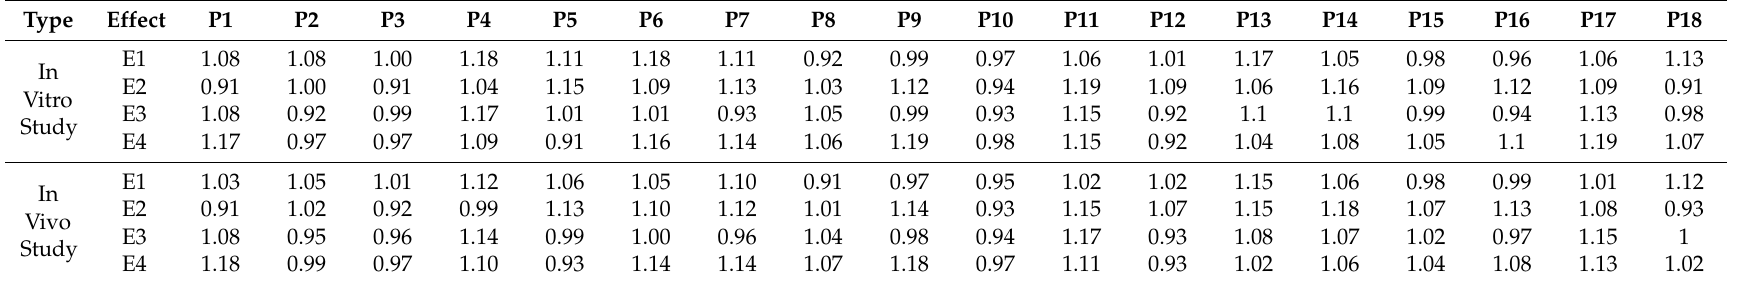
Table 7. The VIP values of the eighteen components (P1–P18) of ten different batches of panax ginseng saponins extracts in vitro and in vivo study in example 2.